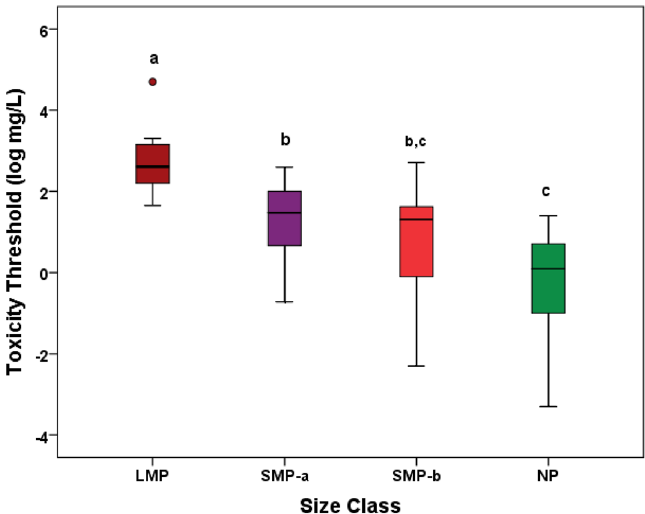
Figure 2. Toxicity thresholds of plastic particles on aquatic organisms. Note the reduction in toxicity threshold, i.e. the increase in toxicity, as particle size decreases. Size classes were defined as: large microplastics (LMP, > 100 µm), small microplastics between > 10 and 100 µm (SMP-a), small microplastics between 1 and 10 µm (SMP-b), and nanoplastics (NP, < 1 µm). Horizontal line: median; box boundaries: 25th and 75th percentiles; bars: range of observed values. LMP shows a potential outlier. Different letters indicate significantly different groups (Tukey, p < 0.05).